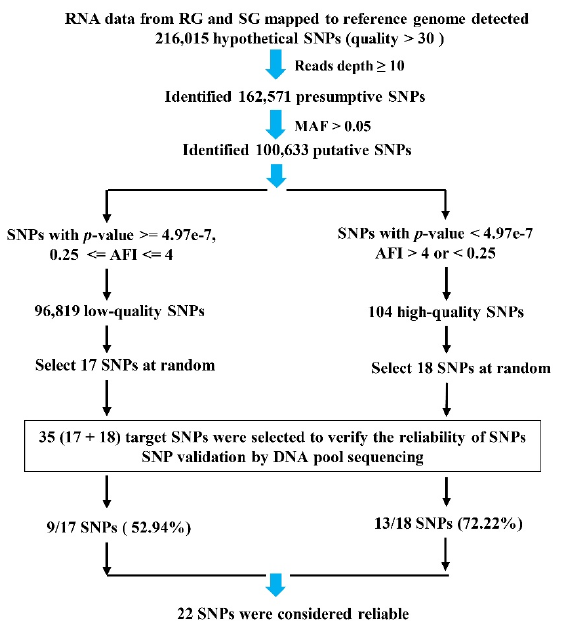
Figure 1. Workflow used to identify SNPs in the P. vannamei transcriptome.